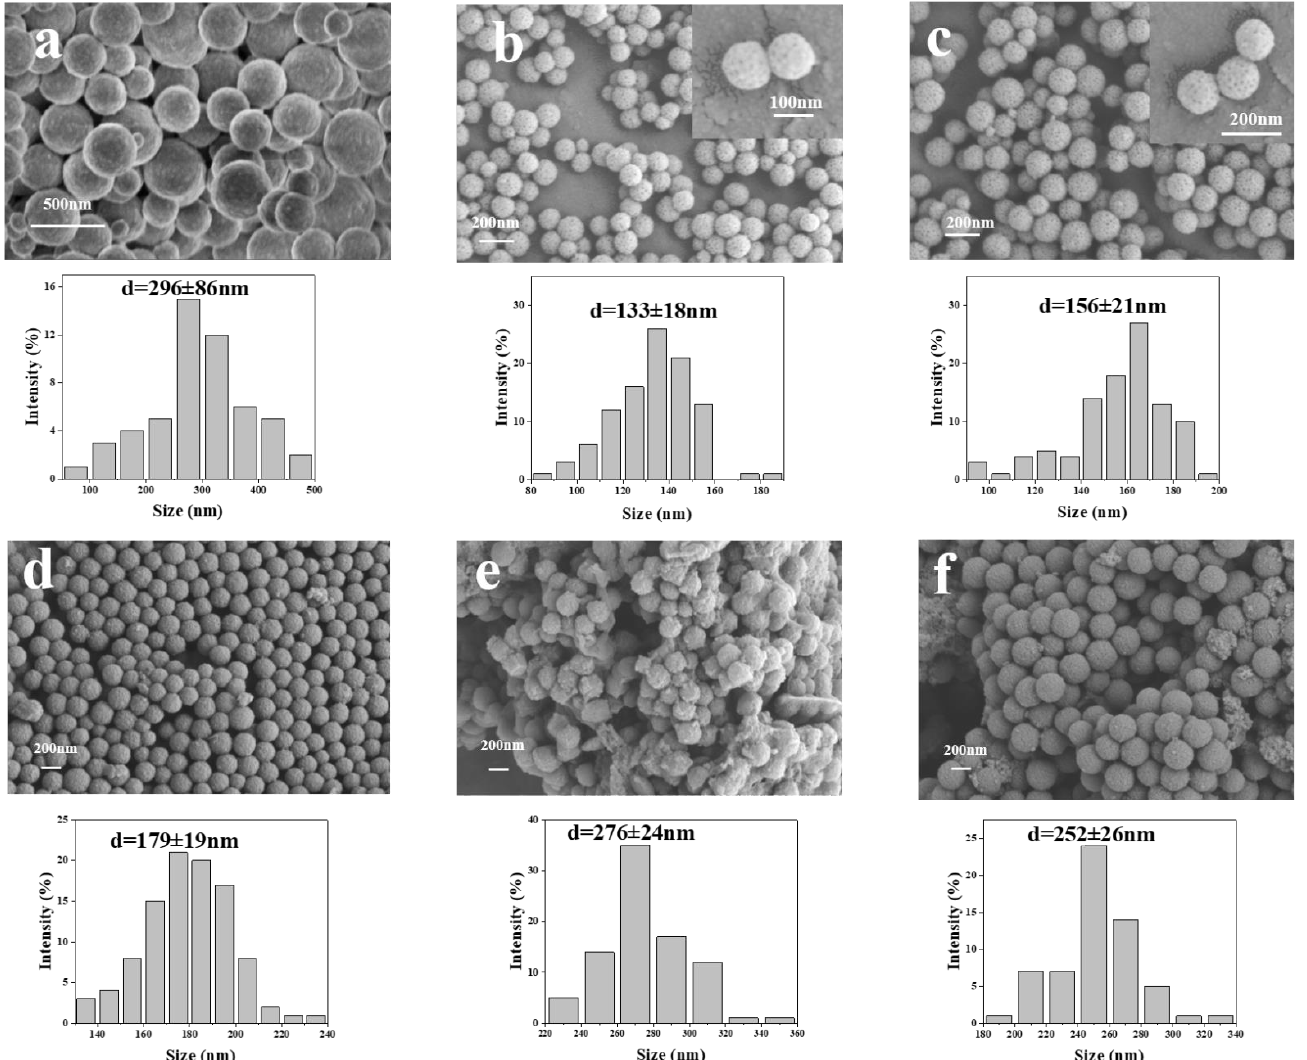
Figure 3. SEM and particle size analysis (template-free dopamine nanoparticles ( a ), acetone–ethanol elution dopamine nanoparticles ( b ), anhydrous ethanol elution dopamine nanoparticles ( c ), m (MPDA-Fe(III)-DOX:HA) = 1:1 ( d ), m (MPDA-Fe(III)-DOX:HA) = 1:2 ( e ), m (MPDA-Fe(III)-DOX:HA) = 1:3 ( f )).